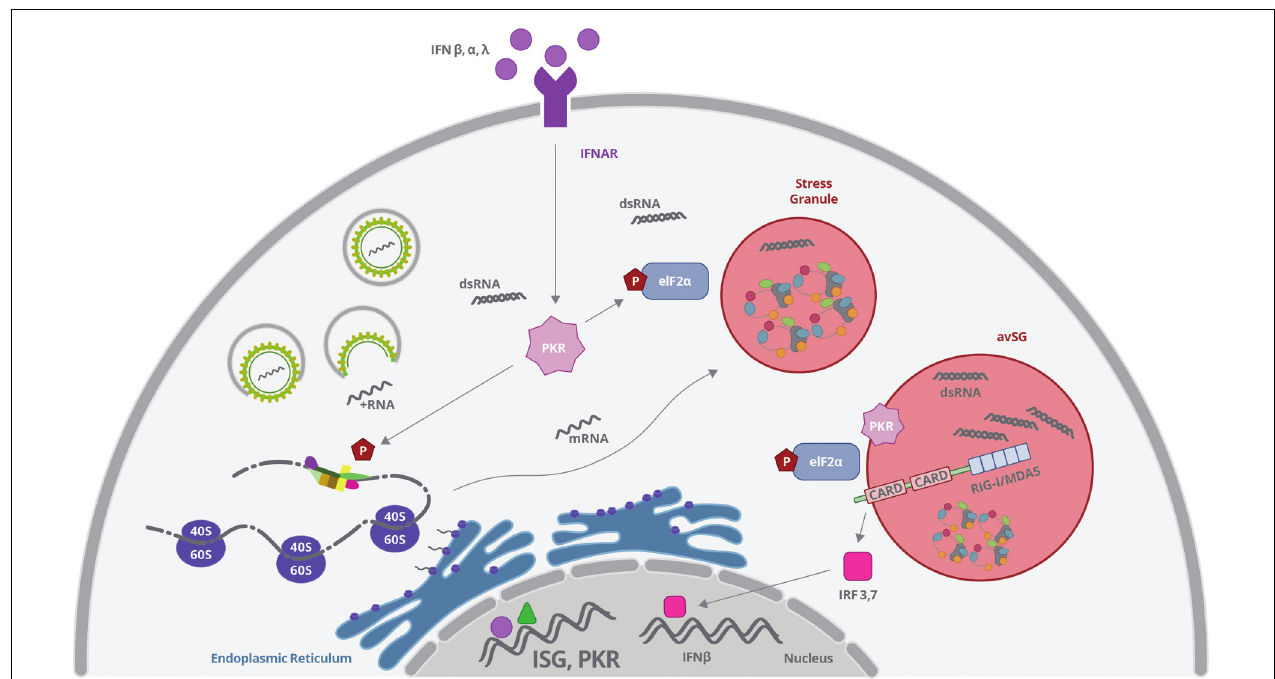
FIGURE 4 | Viruses can induce stress granules (SGs) formation by interfering with translation complexes or by activating PKR. PKR expression is upregulated by type I and III IFN binding to IFNAR and the enzyme is activated by dsRNA recognition. Activated PKR phosphorylates eIF2 α and promotes mRNP aggregation and SG formation. All these events result in inhibition of protein synthesis. RIG-I, MAVS, and PKR can concentrate and colocalize with SGs induced by virus infection, forming the so-called antiviral stress granules (avSG), which may function as a platform for RNA sensing and IFN response